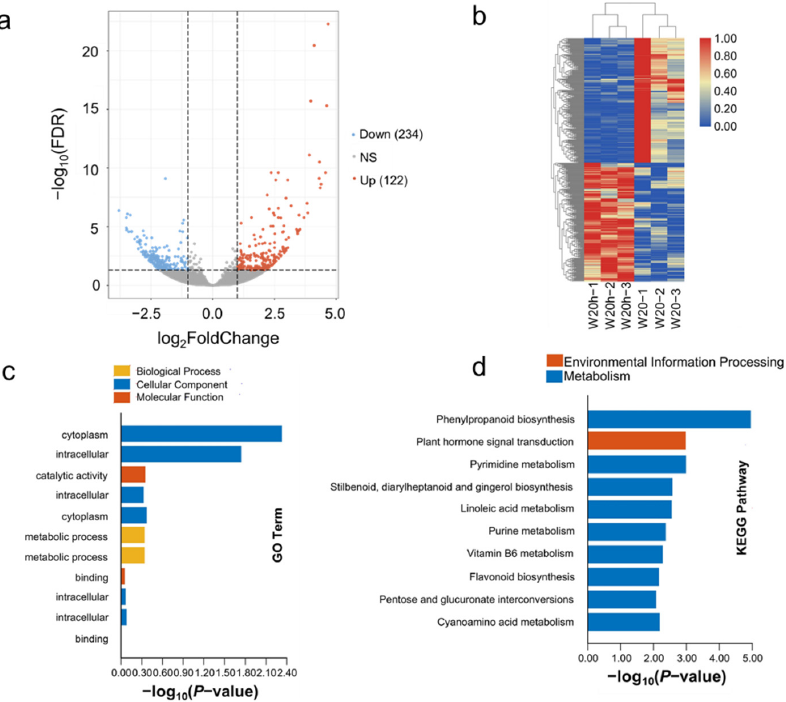
Figure 7. Identification and functional annotation of DEGs between treatment and control, generated using high-throughput deep sequencing technology. ( a ) Volcano plot comparing the expression profiles of DEGs between the W20 and W20h experimental samples. ( b ) Clustering analysis of DEGs between treatments and controls. The scale bar indicates upregulated (red) and downregulated (blue) DEGs. The darker the color, the higher the expression; the lighter the color, the lower the expression. ( c ) Top 3 GO classification of all DEGs of W20 cannabis in the seedling stage. ( d ) The top 10 enriched KEGG pathways of all DEGs of W20 cannabis in the seedling stage.